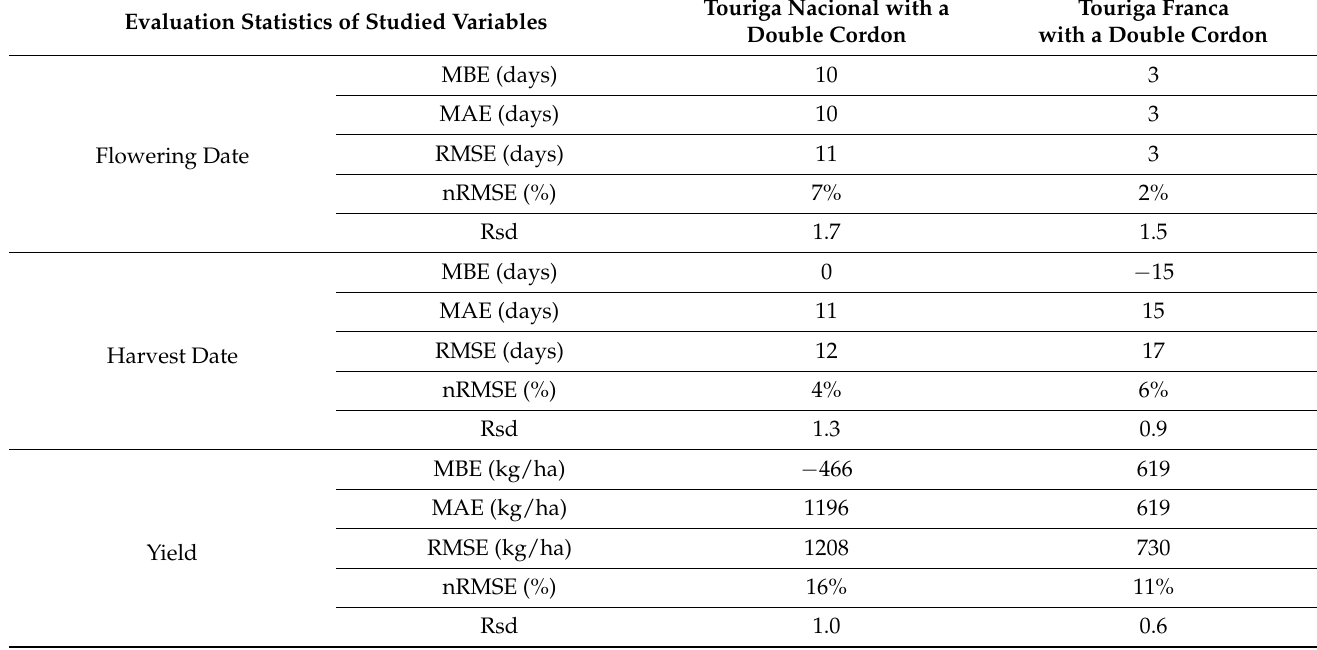
Table 5. Evaluations of the selected parameter vectors identified from the objective function (listed in Table 3) using additional, independent observations. Observational data were obtained from an experimental vineyard (Lat: 41.15 ◦ N, Lon: − 7.75 ◦ W) in the Douro Demarcated Region between 2012 and 2014 for Touriga Nacional (double-cordon system) and between 2012 and 2013 for Touriga Franca (double-cordon system) (Fraga et al., 2015). MBE denotes Mean Biased Error; MAE denotes Mean Absolute Errors; RMSE denotes Root Mean Squared Errors; Rsd denotes the ratio of standard deviation of simulations to that of the